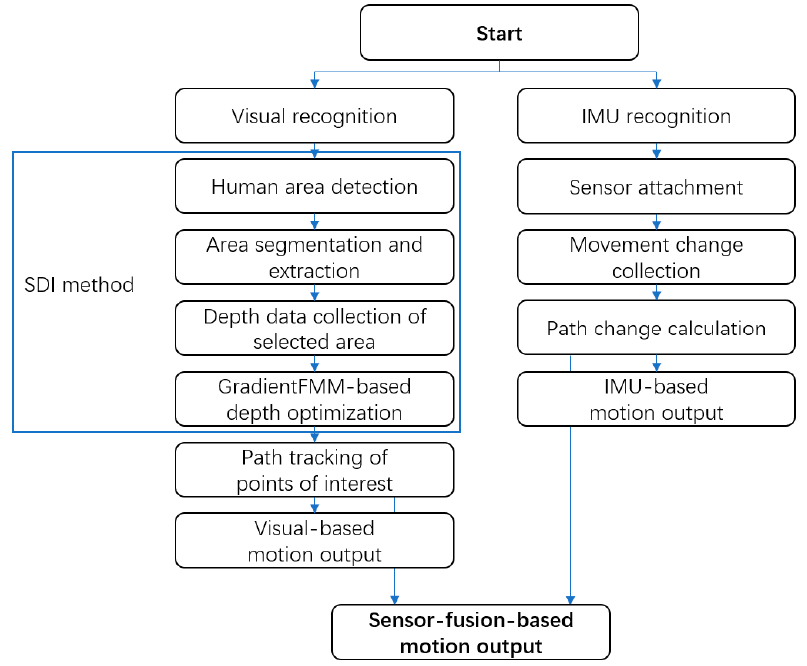
Figure 4. Flow chart of the proposed multi-sensor-based motion